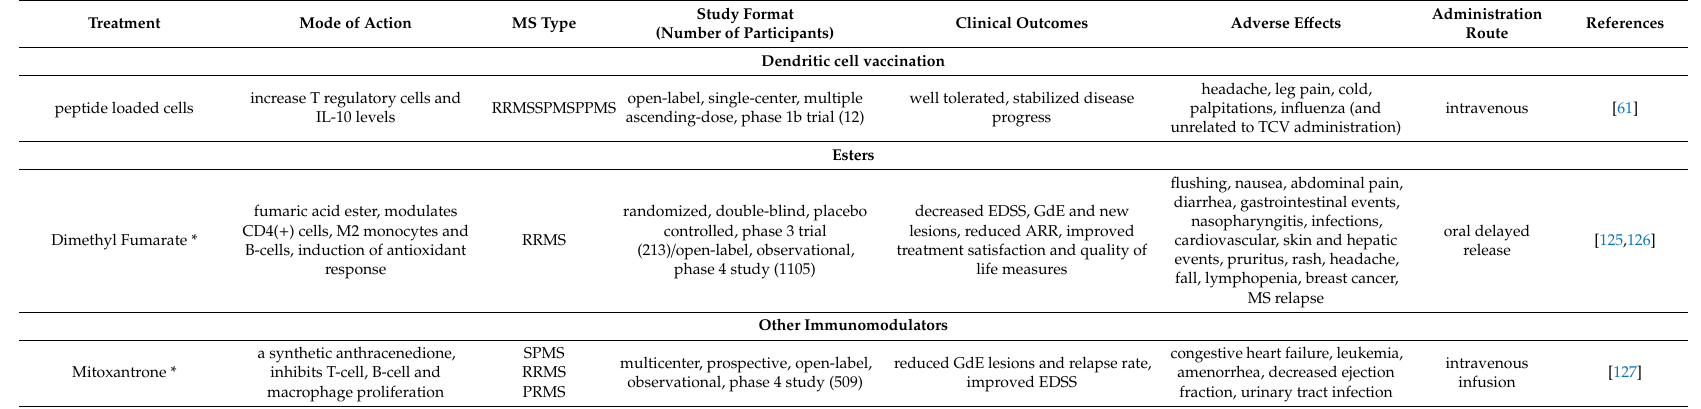
Table 1. The main MS treatments are summarized. Some of them are approved while others are still under clinical trial. Their mode of action and outcomes of some indicative clinical trials are tabulated. With asterisk (*) are indicated the MS medications approved by the FDA. Abbreviations: Antibody (Ab), Altered Peptide Ligand (APL), Annualized Relapse Rate (ARR), B-cell Activating Factor (BAFF), Blood-Brain Barrier (BBB), Confirmed Disability Progression (CDP), Confirmed Disability Worsening (CDW), CerebroSpinal Fluid (CSF), C-X-C motif chemokinebinding Ligand-13 (CXCL-13), DiHydro-Orotate DeHydrogenase (DHODH), deep Gray Matter (dGM), Expanded Disability Status Scale (EDSS), Gadolinium-Enhanced (GdE), Infusion-Associated Reactions (IARs), InterFeroN (IFN), InterLeukin (IL), Leucine rich repeat and Immunoglobin-like domain-containing protein 1 (LINGO-1), Myelin Basic Protein (MBP), myelin oligodendrocyte glycoprotein (MOG), Modified Fatigue Impact Scale (MFIS), Mental Health Inventory (MHI), Medication Satisfaction Questionnaire (MSQ), Multiple Sclerosis (MS), No Evidence of Disease Activity (NEDA), No Evidence of Progression or active Disease (NEPAD), proteolipid protein (PLP), Primary Progressive Multiple Sclerosis (PPMS), Relapsing Multiple Sclerosis (RMS), Relapsing-Remitting Multiple Sclerosis (RRMS), Sphingosine-1-phosphate receptor (S1PR), Symbol Digit Modalities Test